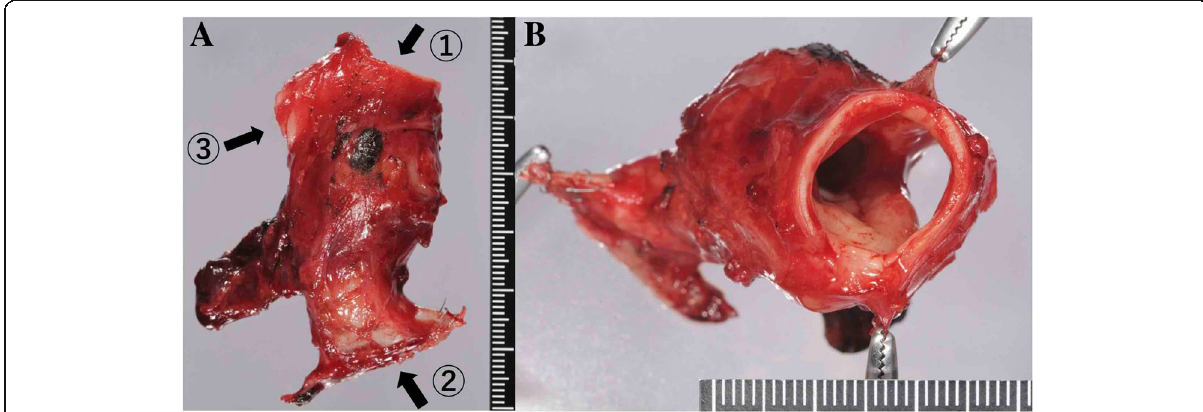
Fig. 4 Macroscopic findings of the resected tracheobronchial tumor. a A front view of the ① tracheal stump, ② left main bronchial stump, ③ right main bronchial stump. b The tumor and carina are observed from the tracheal